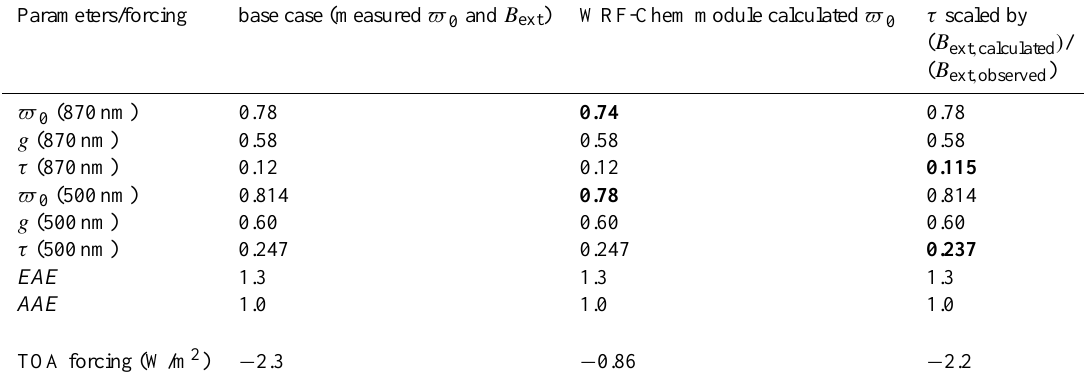
Table 4. SBDART inputs for three cases: (1) a “base case” that uses measured $ 0 and B ext to calculate top of atmosphere (TOA) aerosol radiative forcing, (2) a case that uses the “WRF-Chem optical module” calculated $ 0 in place of the measured $ 0 , and (3) a case that uses the measured τ scaled by the ratio B ext , calculated / B ext , observed . Also shown are the TOA forcings, averaged over 24h at the equinox. These TOA forcings are listed in the last row. The spectral surface albedo is from Coddington et al. (2008). The parameters that are changed from the base case are in boldface